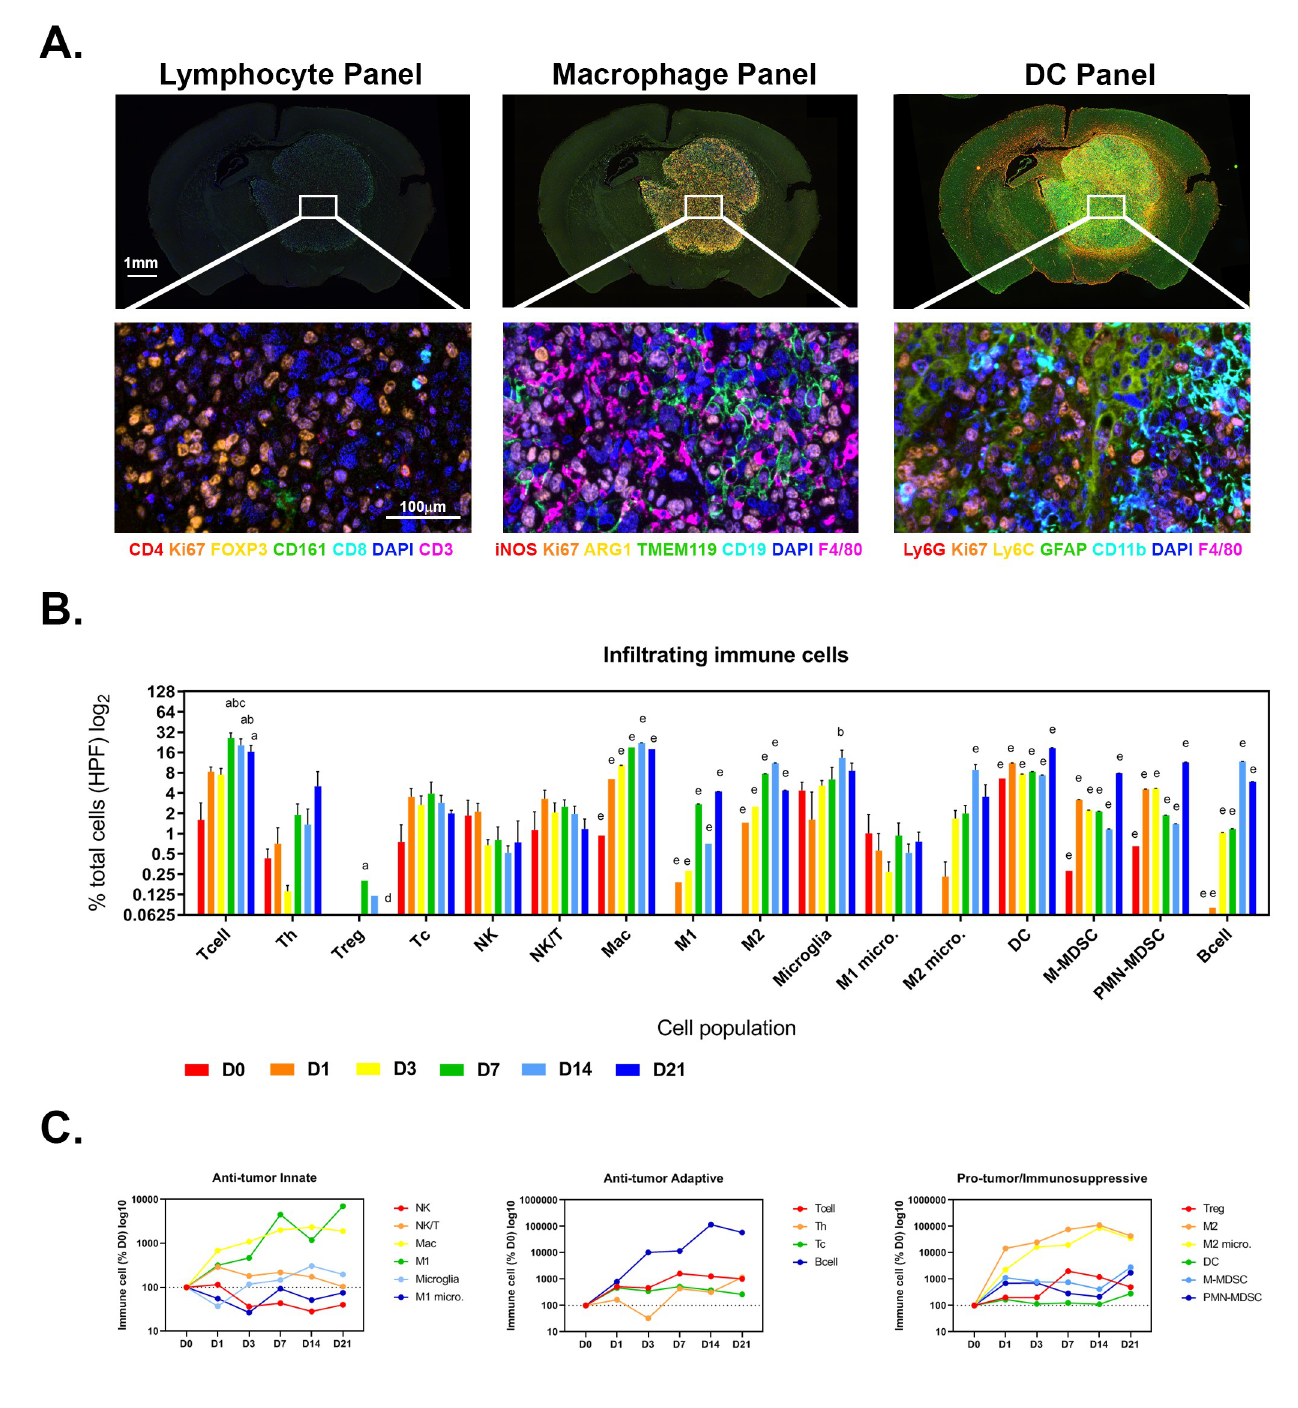
Fig 5. Tumor immune cell infiltrate. (A) Whole slide scans (4x) and MSI spectrally unmixed and pseudo-colored micrographs (20x) of the three immune cell panels for lymphocytes, macrophages and DC populations in the tumor infiltrate. (B-C) Quantitation of immune cell phenotypes in HPF for each murine brain (N = 6 brains per time point). Data are expressed as mean ± SEM per HPF (B) and as mean percentage normalized to day 0 (C). a p < 0.05 vs D0, b p < 0.05 vs D1, c p < 0.05 vs D3, d p < 0.05 vs D7, e p < 0.05 vs all other time points by One-way ANOVA with Tukey’s multiple comparison test.